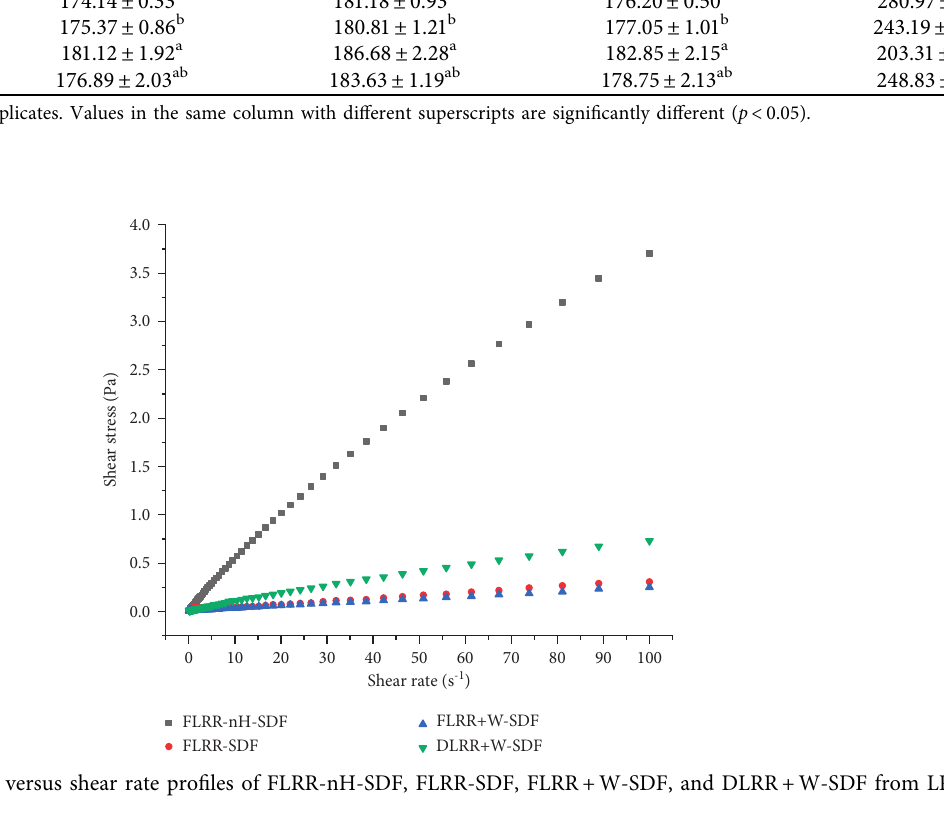
Table 4: Thermodynamic properties of FLRR-nH-SDF, FLRR-SDF, FLRR +W-SDF, and DLRR+W-SDF samples from LRRs.